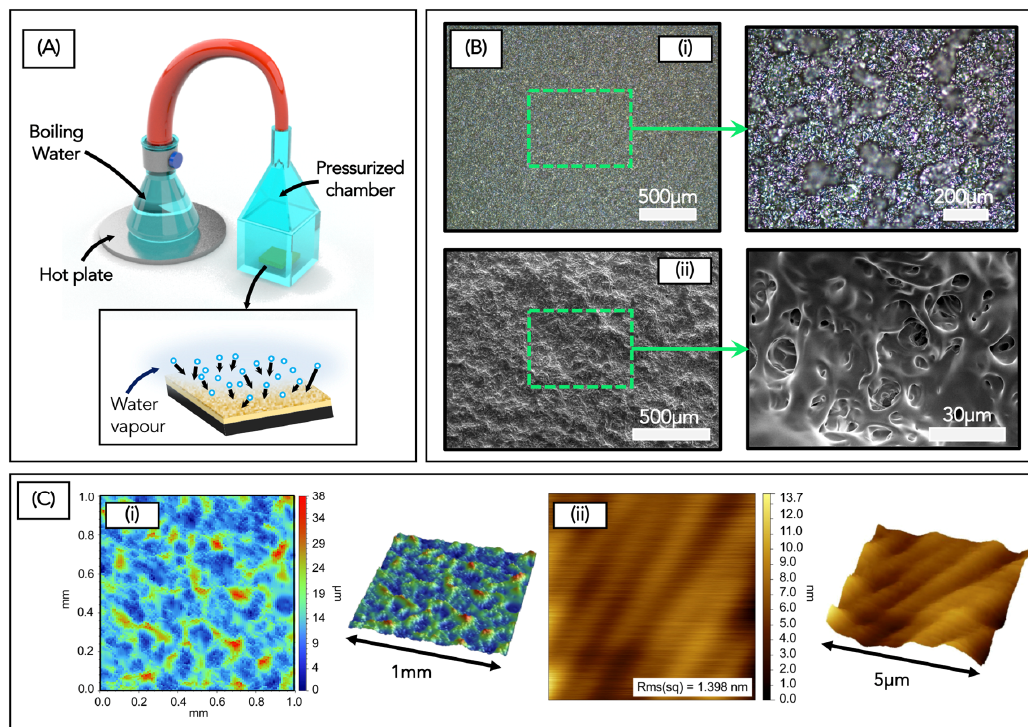
Figure 2. ( A ) Setup used for the steam-curing step to make the PDMS patch rough and porous in the superficial layer; the inset shows the impingement of water vapor particles onto the PDMS surface. ( B ) Optical micrographs (i) and SEM micrographs (ii) showing the morphology of the rough PDMS layer. ( C ) 2D and 3D topography images of the rough PDMS layer, scanned with the profilometer (i) and by AFM (ii), on 1 mm 2 and 5 µm 2 areas, respectively.